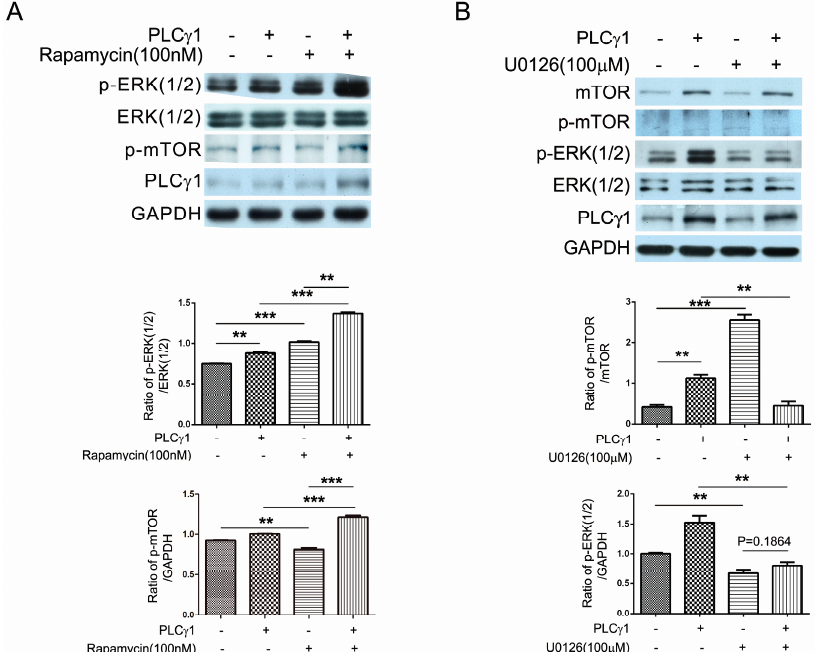
Figure 4. The mutual inhibition of mTOR and ERK in PLC γ 1-transformed human OA chondrocytes. ( A ) Cells were transfected with PLC γ 1 vector for two days followed by the treatment of rapamycin (100 nM) for 2 h, and the levels of ERK(1/2), p-ERK(1/2), p-mTOR, and PLC γ 1 were detected by western blotting analysis using anti-ERK(1/2), p-ERK(1/2), p-mTOR, PLC γ 1 and GAPDH antibodies; ( B ) Cells were transfected with PLC γ 1 vector for two days followed by the treatment of U0126 (100 μ M) for 2 h and the levels of mTOR, p-mTOR, ERK(1/2), p-ERK(1/2) and PLC γ 1 were detected by Western blotting analysis using anti-mTOR, p-mTOR, ERK(1/2), p-ERK(1/2), PLC γ 1 and GAPDH antibodies. The blots were normalized to an endogenous protein (GAPDH). The values represent the mean ± SEM of three or five independent experiments (patients), each yielding similar results ( ** p <0.01, *** p <